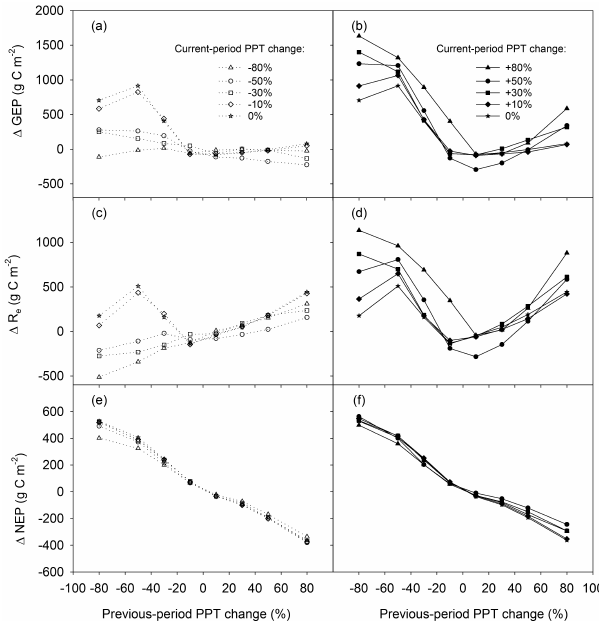
Figure 3. Interdecadal legacy effects of changing the previous- period (1981–1994) precipitation on the cumulative carbon fluxes of the current period (1995–2010). Interdecadal legacy effects on carbon fluxes (e.g., (cid:49) NEP) are calculated as the difference between the current-period flux with previous-period PPT changes and that without previous-period PPT changes. Dashed lines with open sym- bols represent different levels of decreasing the current-period pre- cipitation (left panels). Solid lines with filled symbols represent in- creasing the current-period precipitation (right